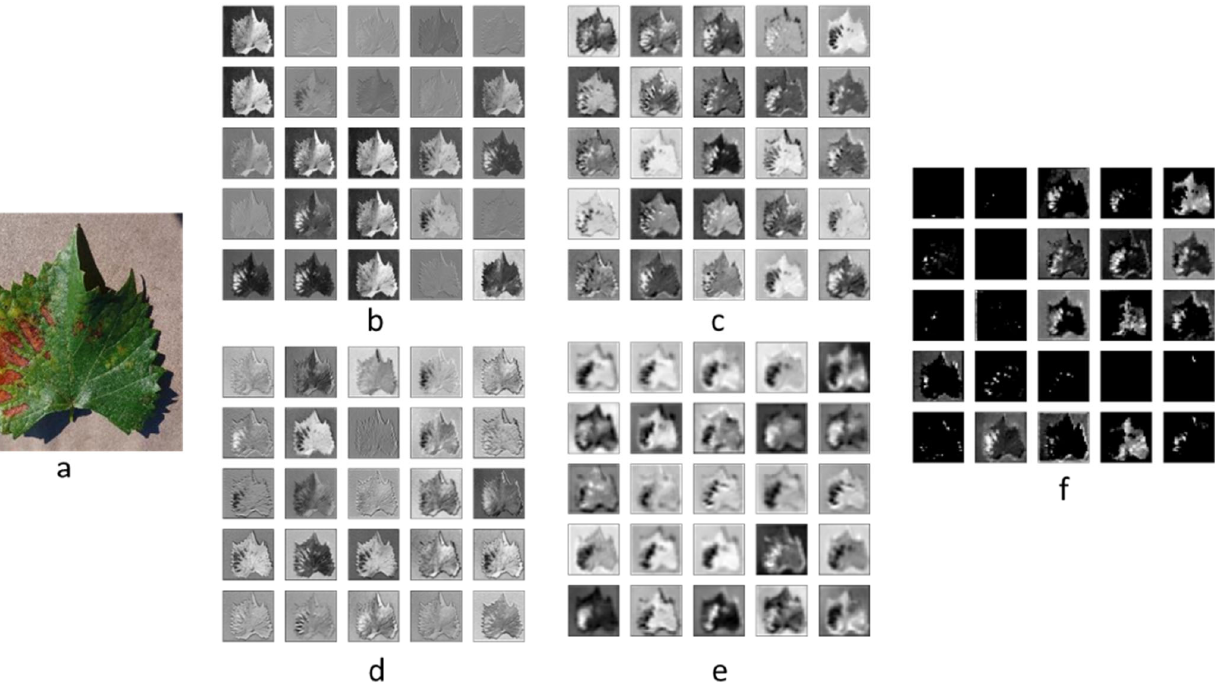
Figure 7. Visualizing the Convolutional Kernel of Grape disease. ( a , b ) shows the features of the first layer of the network. Subsequently, extracted features edges are started to focus on the grape black measles disease. Moreover, ( c , d ) is the second and third layer of the network, which displays the affected area. In ( e , f ) is the last two ‐ layer which represents the most relevant feature details of the disease.